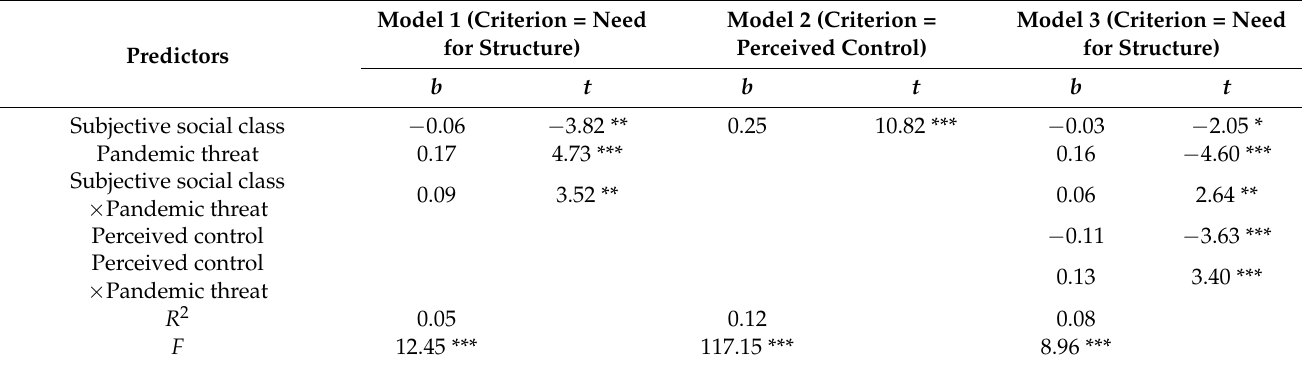
Table 3. Multiple regression analyses of moderated mediation